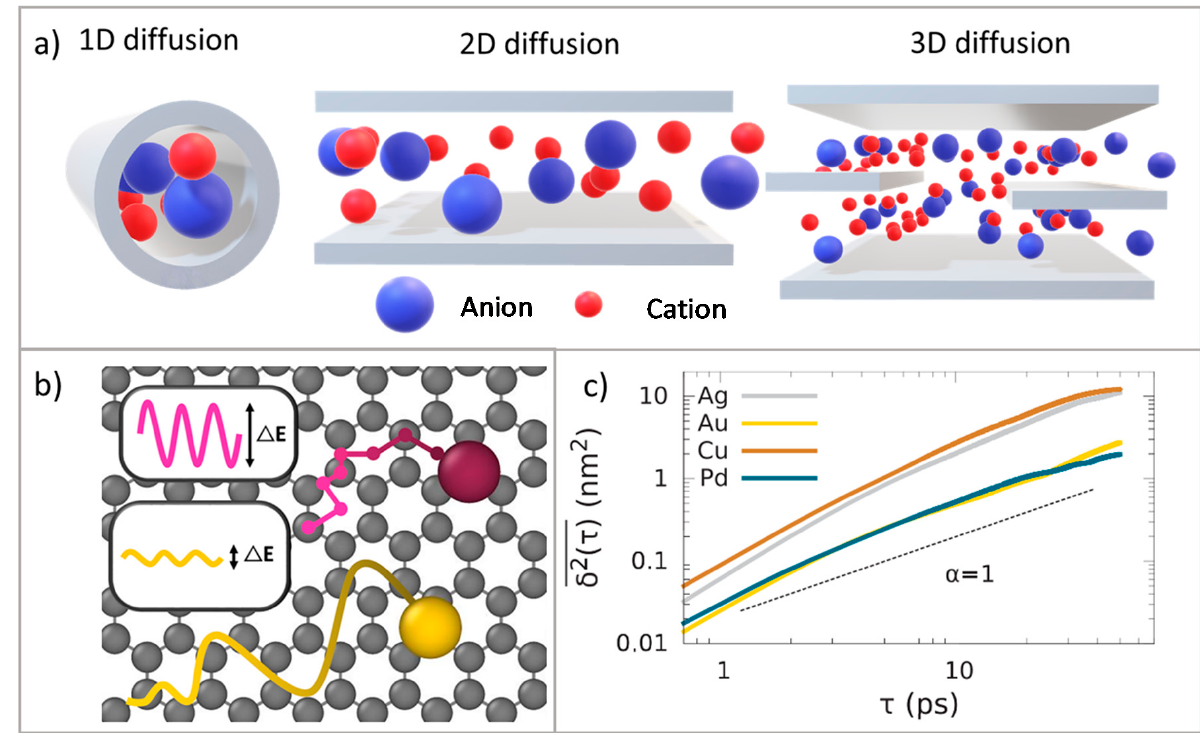
Figure 17. ( a ) Diffusion of ions in one, two and three dimensions due to boundary restrictions. ( b ) 2D diffusion of metal ions on graphene (purple shows diffusion with local potential restriction and yellow shows Levy walk behavior in a super-diffusive regime). ( c ) The relationship between the power law of mean square displacement ( δ 2 or < 𝑟 (cid:2870) > ) and the time steps ( τ ) of individual metal ions based on computational simulation [134]. Reproduced with permission from ( a ) ref. [134] Copyright (2020), American Chemical Society.